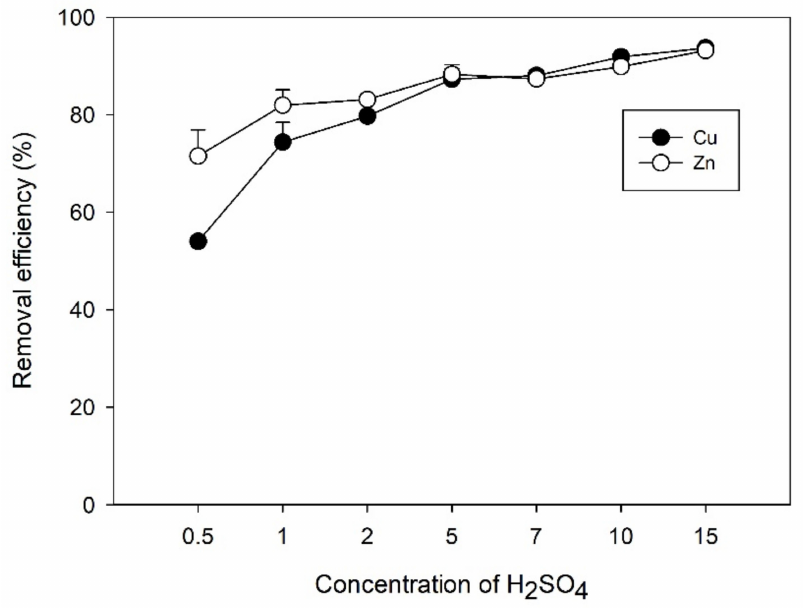
Figure 2. The influence of concentrations of H 2 SO 4 (%) on removal efficiency of Cu and Zn from swine feces (reaction time: 5 h, solid to liquid ratio: